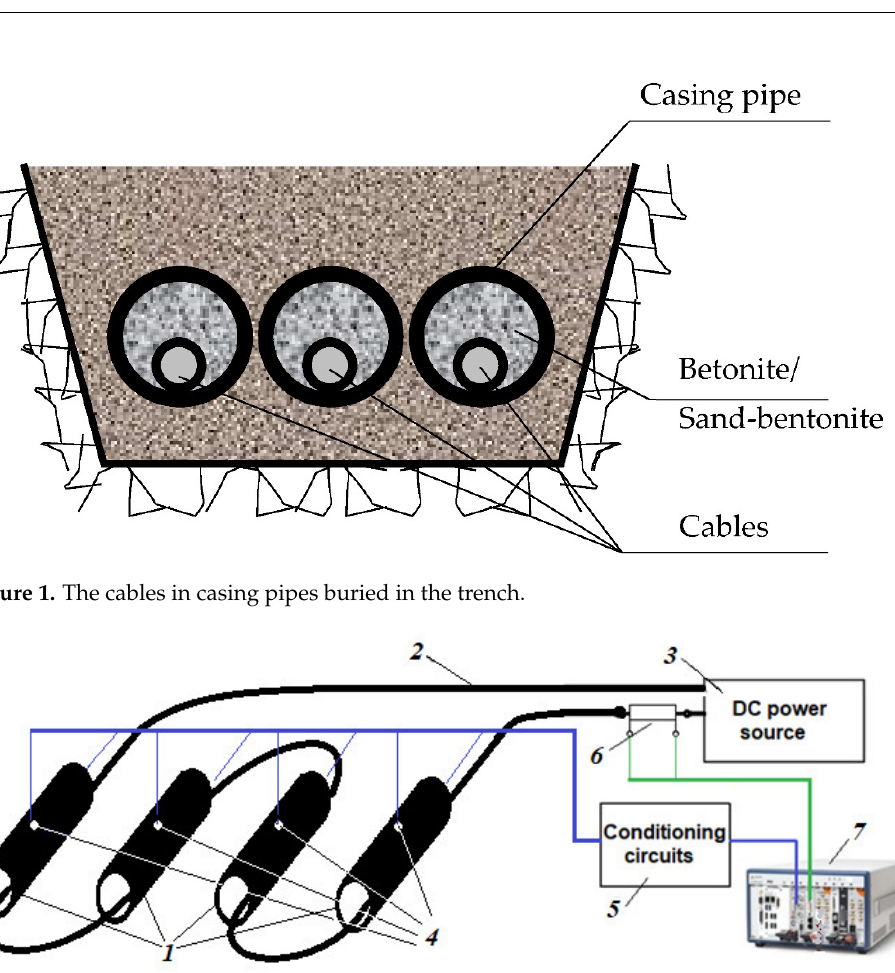
Figure 2. The main elements of the test stand: ( 1 )—a set of casing pipes; ( 2 )—a copper cable; ( 3 )—a set of current power supplies; ( 4 )—miniature hermetic thermistor sensors; ( 5 )—signal conditioning circuits; ( 6 )—shunt; ( 7 )—PXI measurement system.